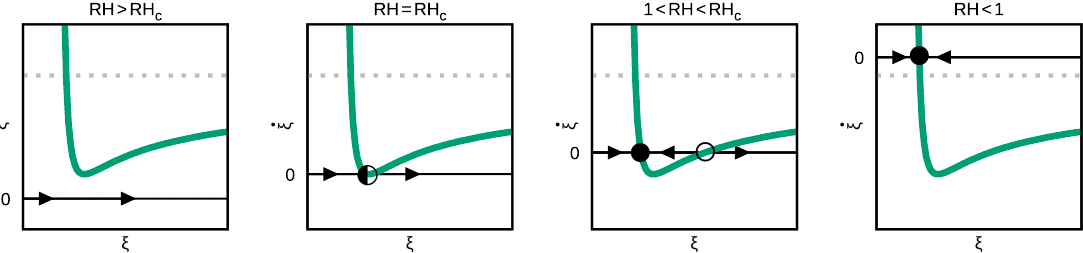
Figure 1. Phase portraits of the system discussed in Sect. 3 for different values of the control parameter RH. Arrows have their heads pointing right (left) if the sign of ˙ ξ is positive (negative). The half-filled circle denotes a half-stable fixed point. Filled and open circles denote stable and unstable fixed points, respectively. The dashed line corresponds to RH = 1.